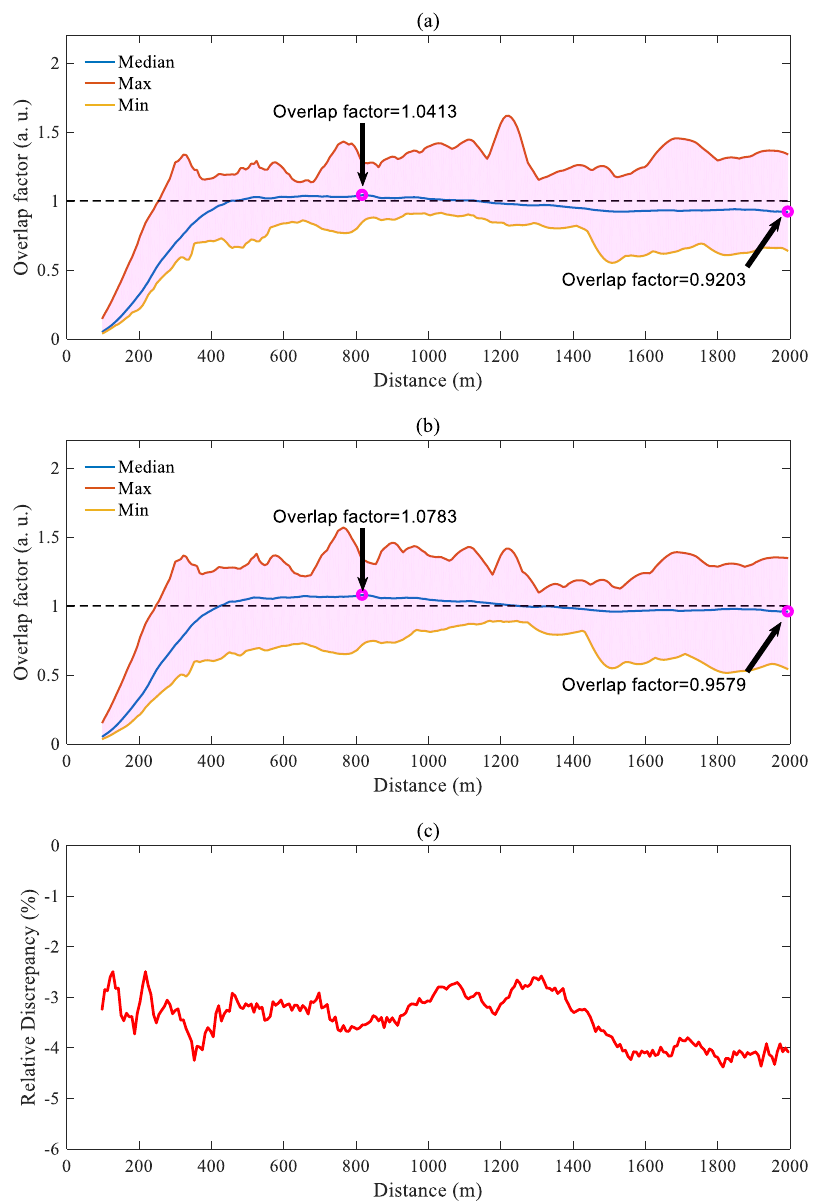
Figure 7. ( a ) Overlap factor with the system constant calibrated in the region of 500–1500 m, ( b ) overlap factor with the system constant calibrated in the region of 1050–1500 m, and ( c ) the discrepancy between the overlap factors. The Median, Max (Maximum) and Min (Minimum) curves were evaluated from lidar curves recorded during the whole measurement period.